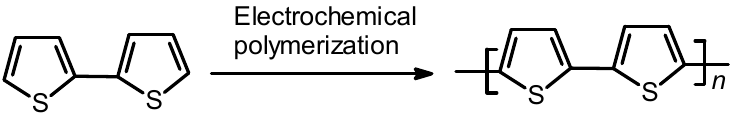
Figure 15. Electrochemical polymerization of bithiophene on V-CB(PANI) with the cyclic voltam- metry method. Arrows indicate scanning directions.